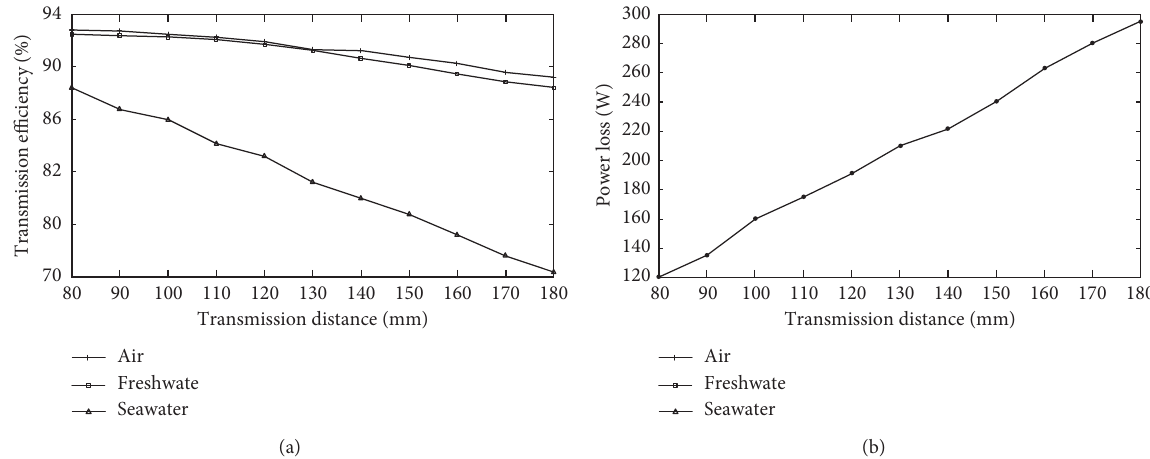
Figure 17: Transmission characteristics with fixed input power. (a) Transmission efficiency with fixed input power. (b) Power loss and transmission distance in